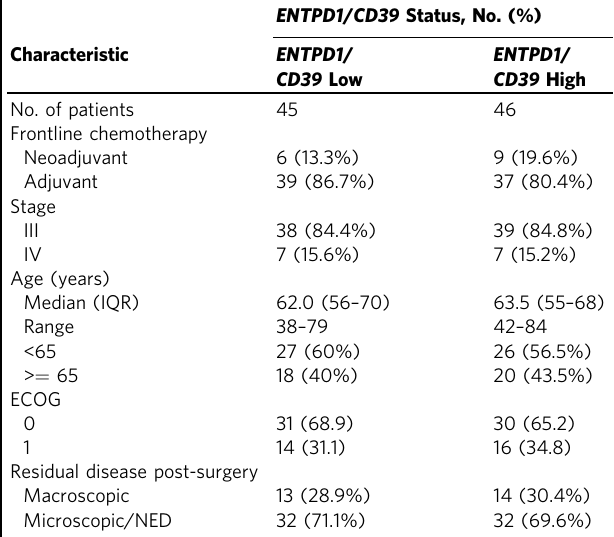
Table 1 Demographics summary of all patients by ENTPD1 / CD39